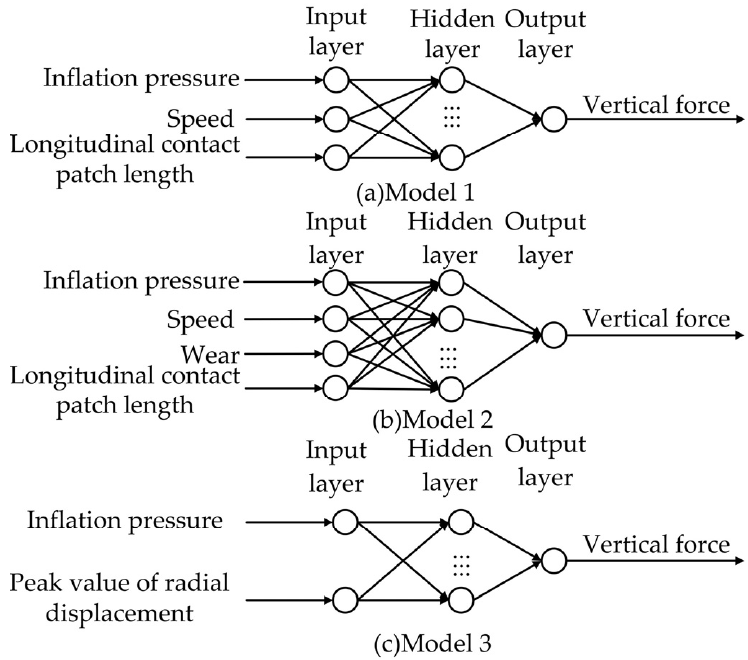
Figure 29. The relationship between the MSE value and the number of hidden nodes.